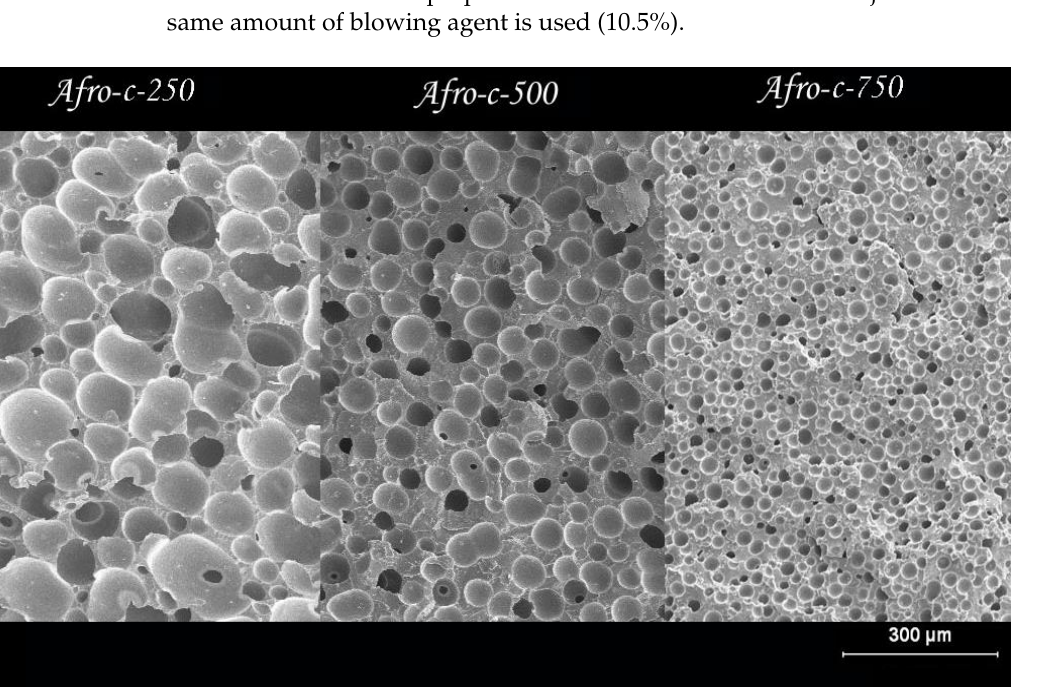
Figure 8. SEM images of the cellular ρ of foams produced with the same amount of blowing agent and three different relative densities. Table 2. Relative density, cellular diameter, cell density of foams, nucleating sites (N-P/cm 3 ) and number of nucleating sites needed to produce a cell (N-P/cell) produced with a CBA content of 10.5% and different relative densities.